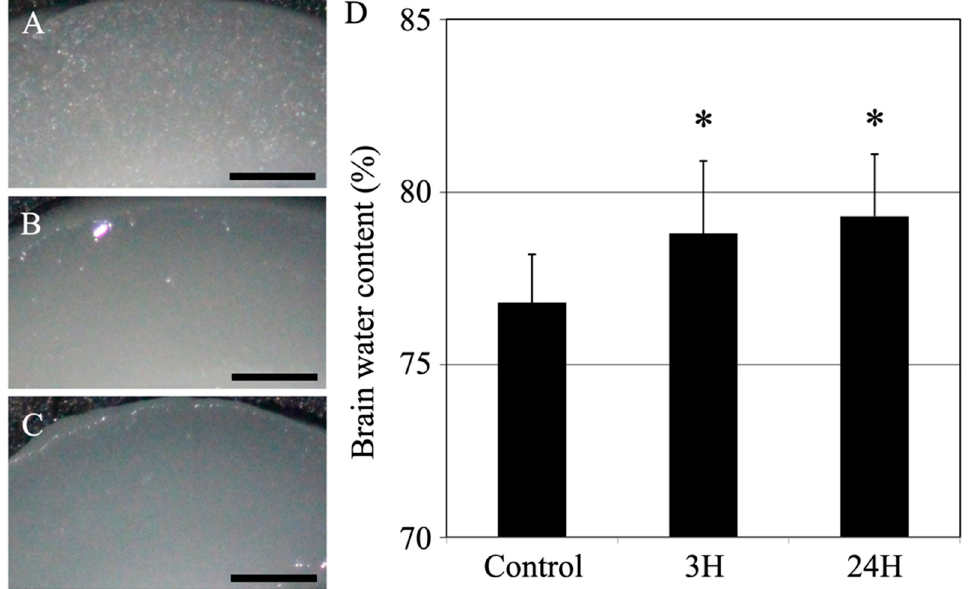
Figure 4. Control ( A ), 3H ( B ), and 24H ( C ) representative images of the cerebral cortical tissues from the control animals and those from animals sacrificed at 3 h and 24 h after ammonia treatment, respectively. All scale bars = 500 µm. ( D ) Control, 3H, and 24H indicate the brain water contents for the animals in the control group and the treated animal at 3 and 24 h after ammonia treatment, respectively. Data are expressed as the mean ± standard deviation. *: p < 0.05 compared with the control value.